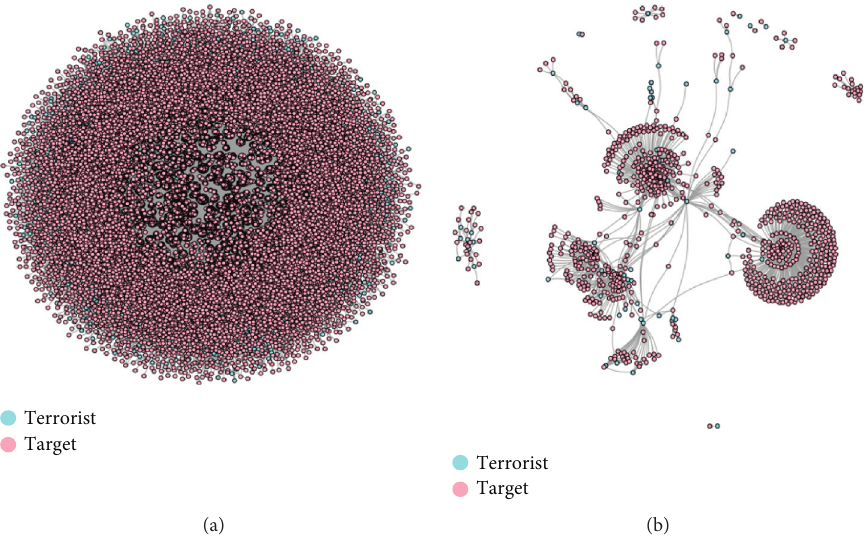
Figure 2: The graphical representation of (a) the original network and (b) the extracted TPKS-skeleton network both exhibit relationships between two classes of nodes: terrorists and targets. Table 1: Top 20 terrorists of the skeleton network comparing with the original global terrorism network. Original